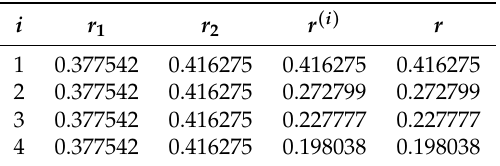
Table 2. Distinct radii of